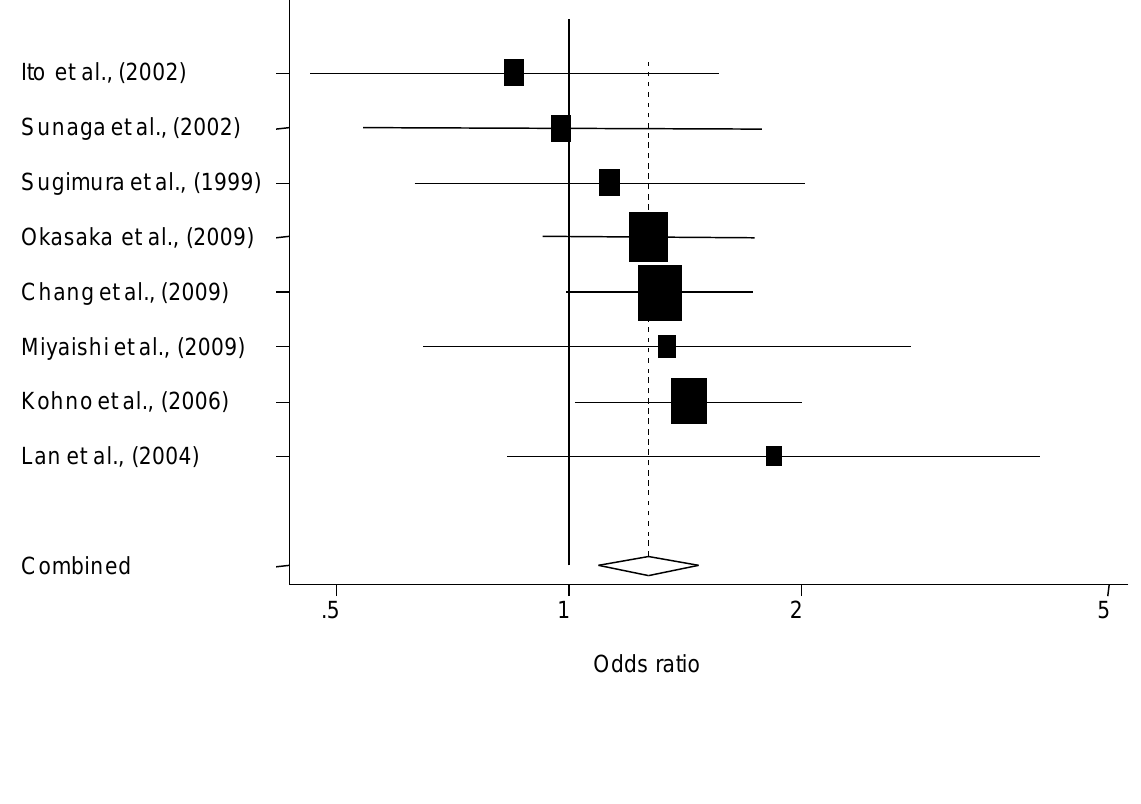
Figure 2. Meta-analysis of eight Asian studies of lung cancer and the hOGG1 Ser326Cys polymorphism (Cys/Cys vs. Ser/Ser). The center of a box and the horizontal line (logarithm) indicate the odds ratio (OR) and the 95% confidence interval (CI) in each study, with the areas of the boxes representing the weight of each study. The summary OR based on random effects model is represented by the middle of a diamond whose width indicates the 95% CI. The summary OR is shown by the dotted vertical line. Summary